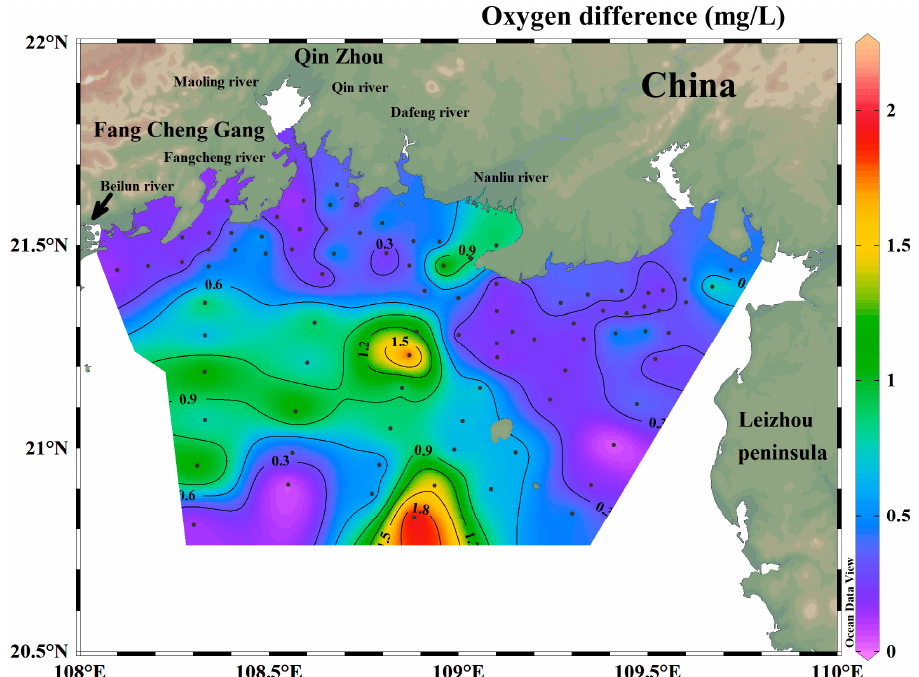
Figure 9. Dissolved oxygen difference between surface and bottom layer.